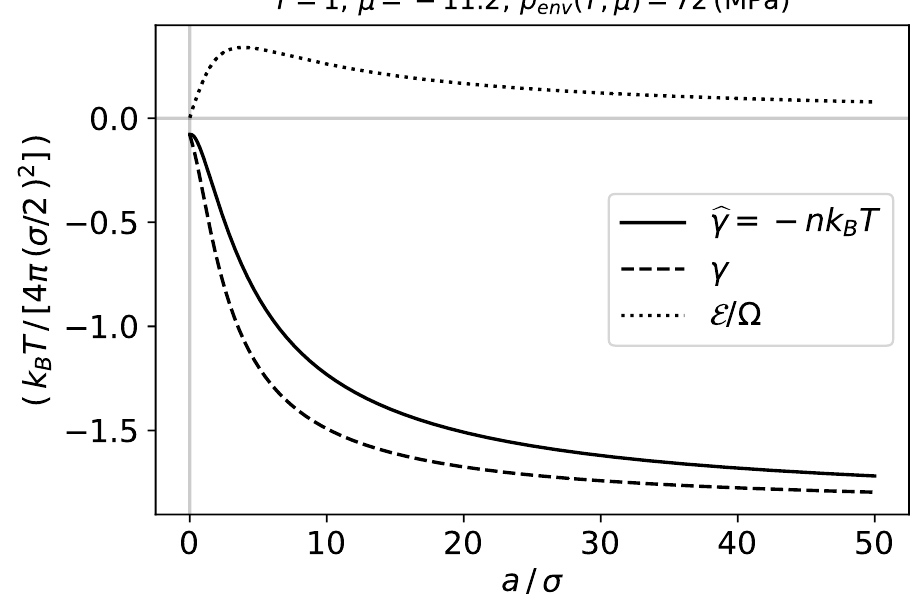
Figure 2. Adsorbed phase thermodynamic quantities per unit area at constant temperature and chemical potential. The figure shows that when the system is small the characteristic energy of the adsorbed phase per unit area depends on the size of the adsorbent. The transition from small to macroscopic is continuous and may reasonably be considered to be beyond 50 σ for this